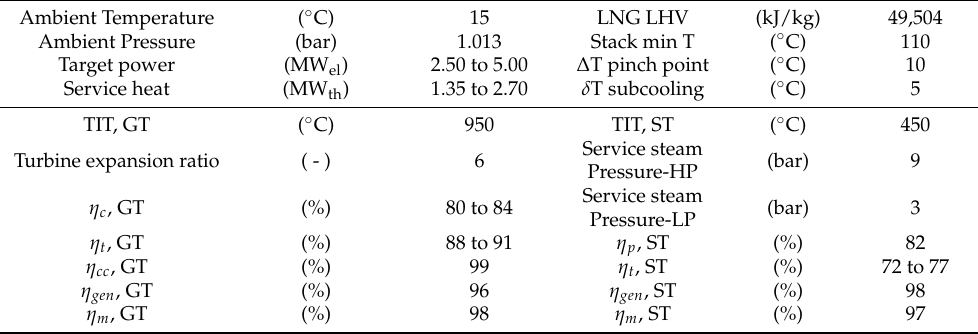
Table 4. Parameters set for plants